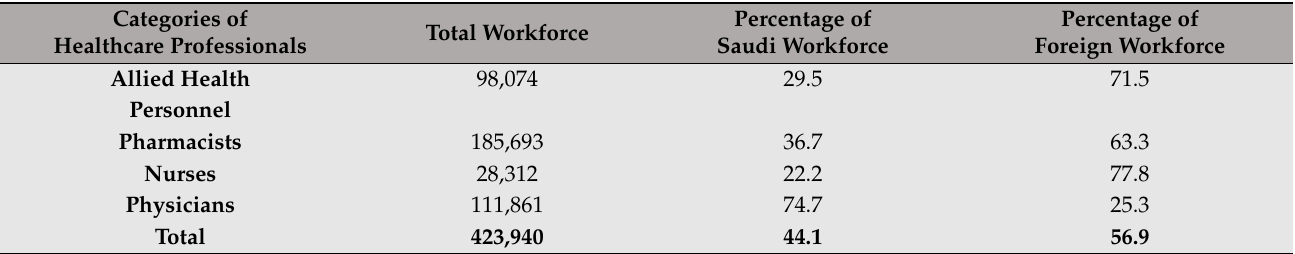
Table 1. Healthcare professionals employed in the KSA as of 2017